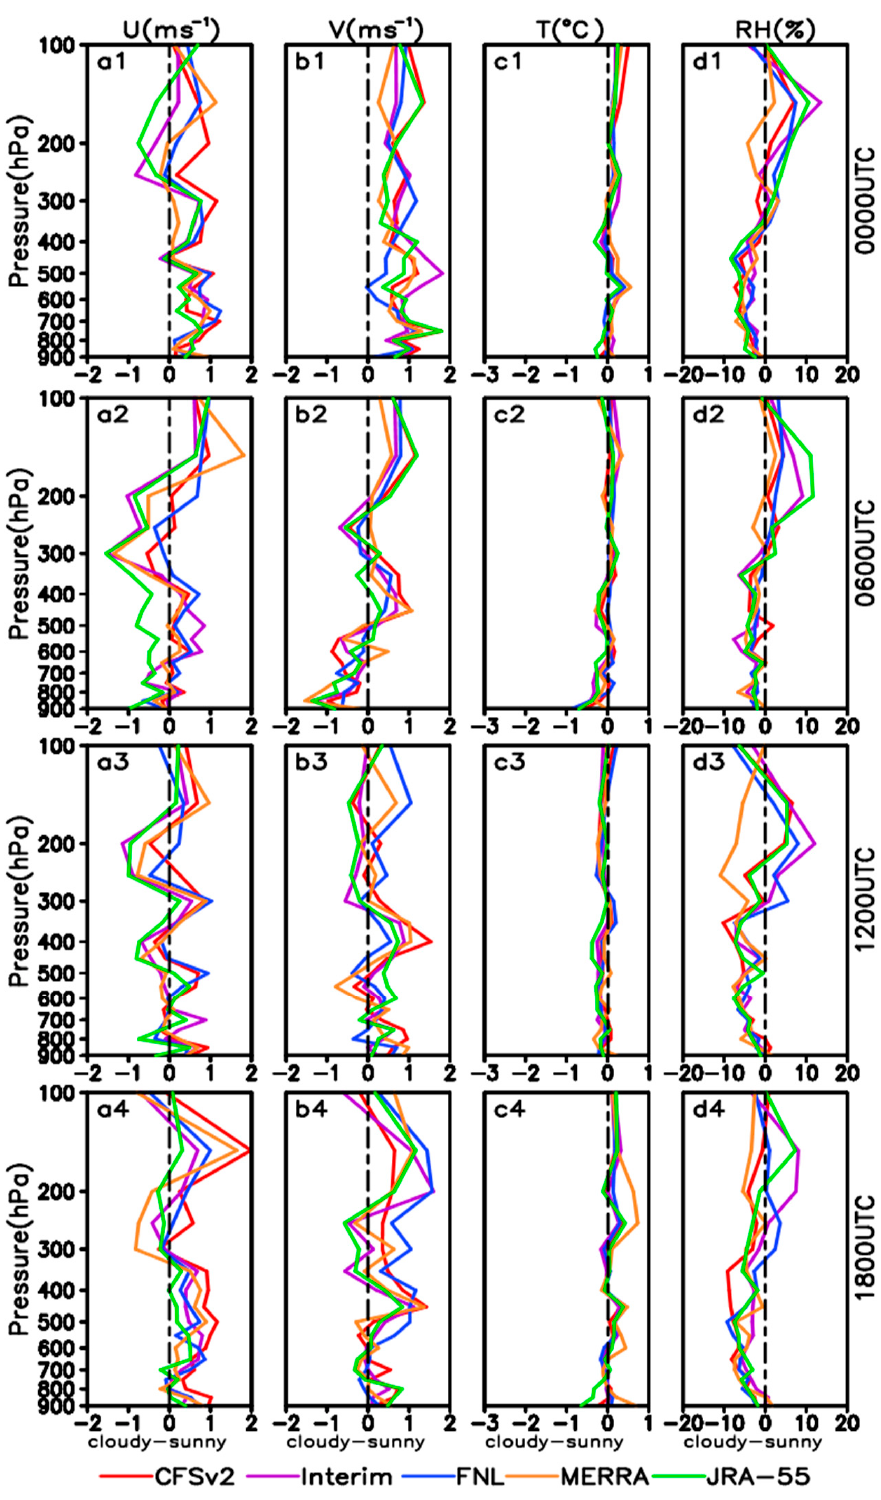
Figure 8. The difference of the RMS errors of U ( a1 – a4 ), V ( b1 – b4 ), T ( c1 – c4 ), and RH ( d1 – d4 ) between those occurring on cloudy days and on sunny days in the GDs against the radiosonde data, averaged over sounding five sites in the basin.